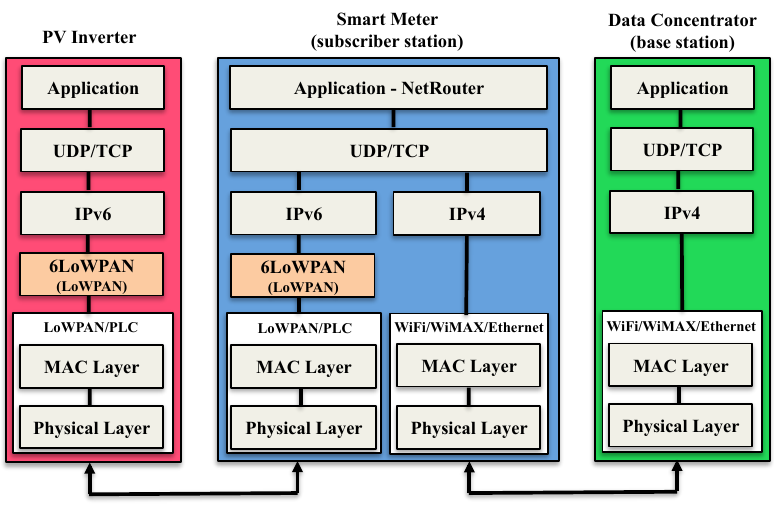
Figure 2. NS3 simulation model of hybrid architectures with user datagram protocol (UDP)/ transmission control protocol